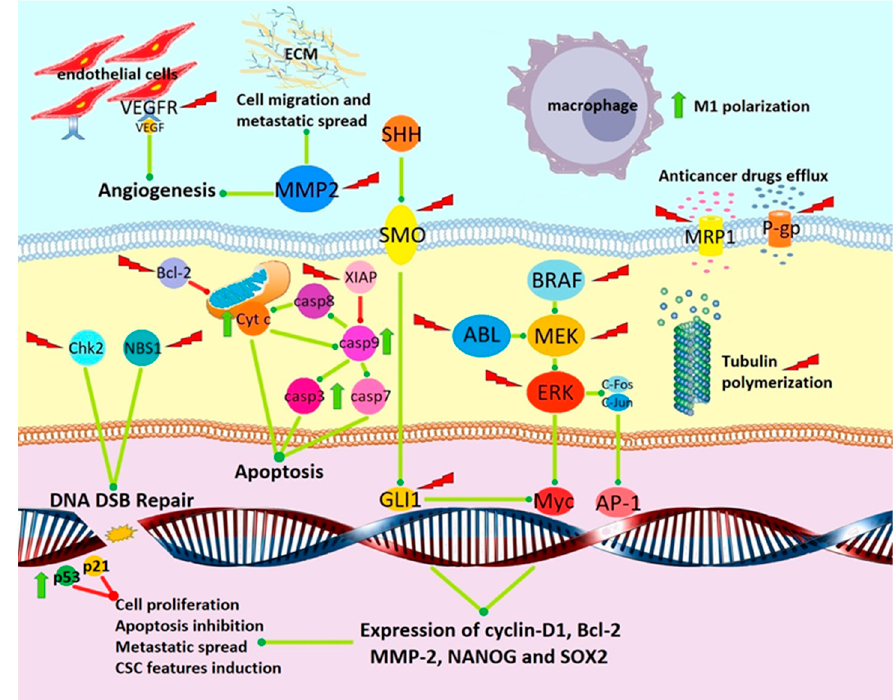
Figure 2. Schematization of antitumoral e ff ects of MBZ. Green lines = induction and / or activation; red lines = inhibition and / or downregulation; green arrow = induction / overexpression induced by MBZ; red lightning bolt = inhibition / downregulation / degradation induced by MBZ. ECM = extracellular matrix; Cyt c = cytochrome c; casp3-7-8-9 = caspase 3-7-8-9; CSCs = cancer stem